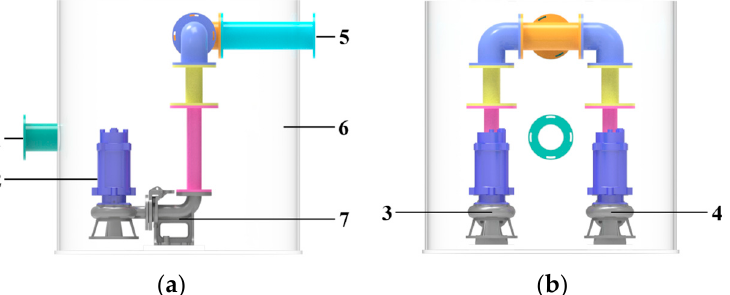
Figure 1. The 3D model structure of centrifugal prefabricated pumping station: 1. Inlet; 2. Motor; 3. Submersible centrifugal pump A; 4. Submersible centrifugal pump B; 5. Outlet; 6. Prefabricated bar- rel; 7. Coupler. ( a ) Side view. ( b ) Front